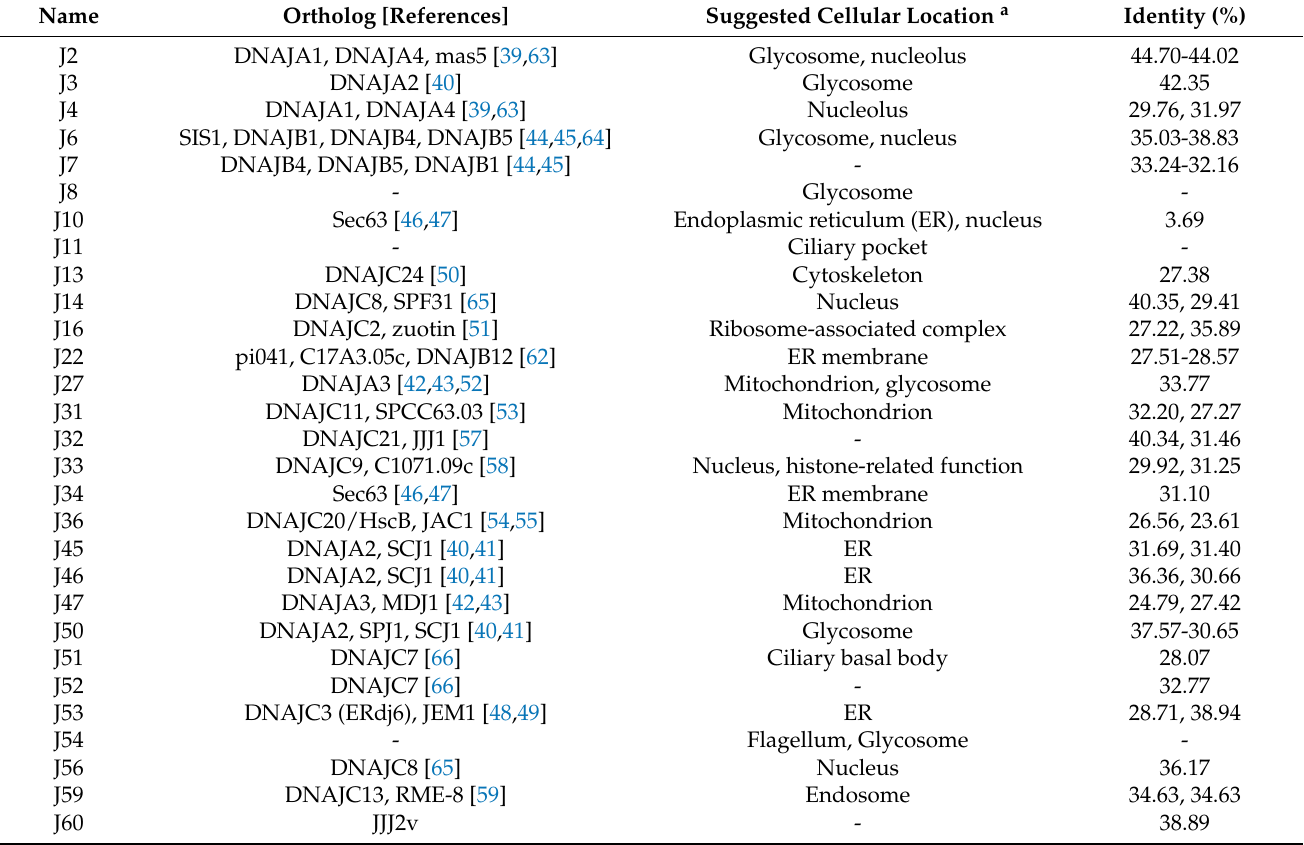
Table 2. Leishmania HSP40 members with possible orthologs in human and/or